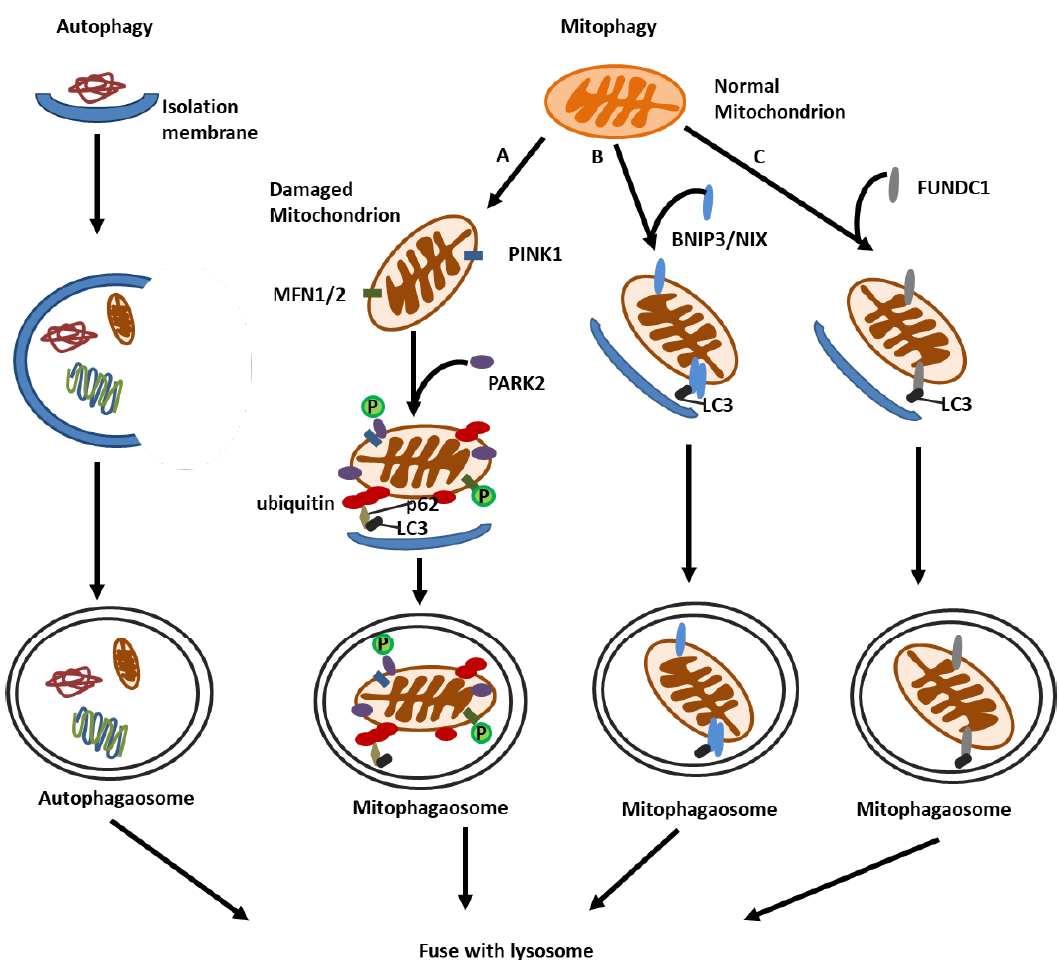
Figure 3. Molecular mechanisms of autophagy and mitophagy. Autophagy involves the formation of isolation membrane, its extension and enclosing of cytoplasmic contents to form the autophagosome, and fusion of the autophagosomes with lysosomes to form the autolysome. Mitophagy is a selective form of autophagy for the clearance of superfluous or damaged mitochondria. There are three well-characterized pathways of mitophagy: (A) PINK1-PARK2 pathway. Under the condition of mitochondrial depolarization, PINK1 accumulates on the mitochondrial outer membrane (MOM), where it phosphorylates and recruits PARK2 E3 ligase to mitochondria and build uibiquitin chains on MOM proteins. The ubiquitinated proteins recruit receptor proteins, such as p62 / SQSTM1, which link the ubiquitin-labelled mitochondria to LC3 in autophagosome membrane, leading to the formation of mitophagosome and mitochondrial degradation. BNIP3, NIX(B) and FUNDC1(C) are MOM proteins that directly bridge mitochondria with LC3 in autophagosome membrane to form